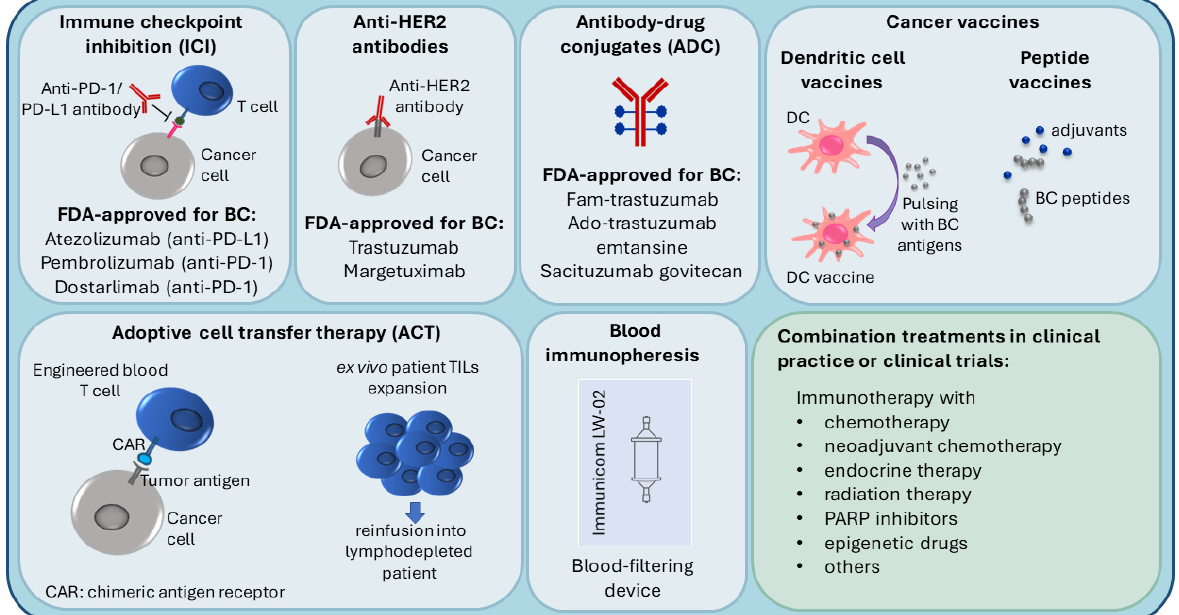
Figure 2. Current immunotherapy strategies in breast cancer treatment.